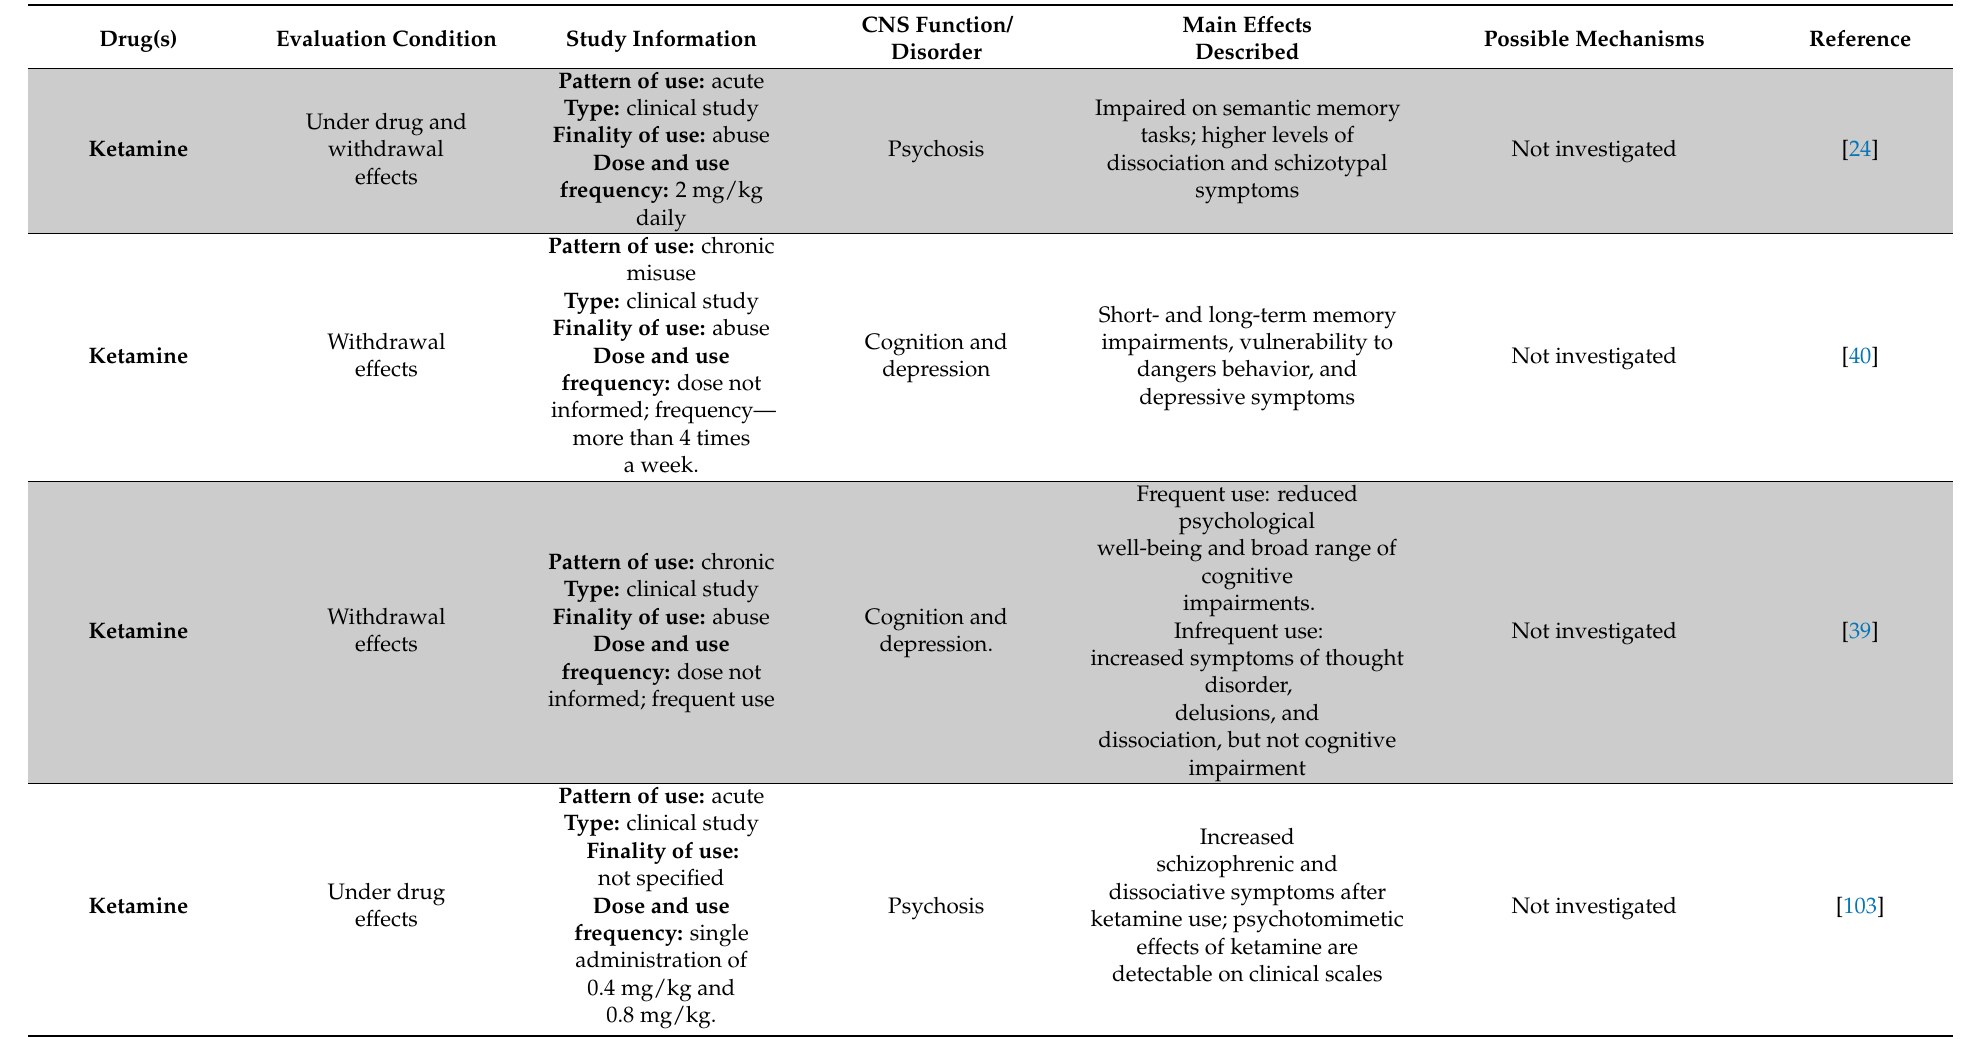
Table 2. Effects reported in studies about ketamine and ethanol solely or combined on cognition, emotionality, and schizotypal